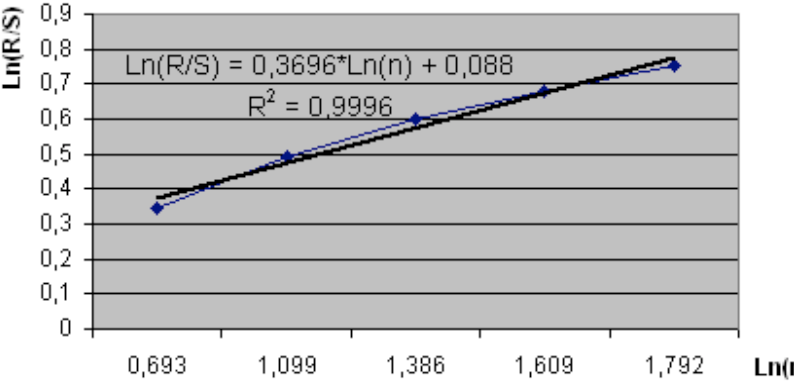
Fig. 1. The dependence (Ln(R/S) from Ln(n) (natural logarithm of the average value of R/S on the natural log of the length of the adjacent period n) of the Cooper test of the control group.